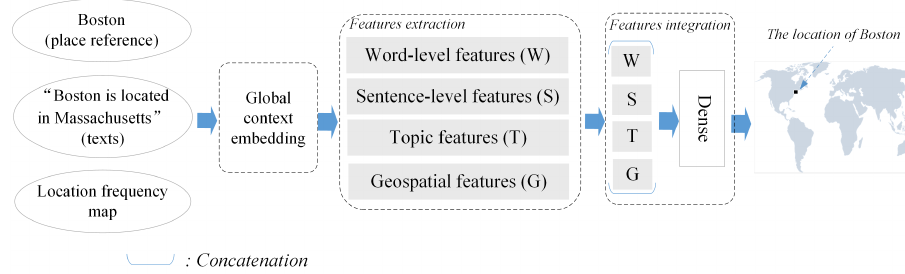
Figure 4. The framework of